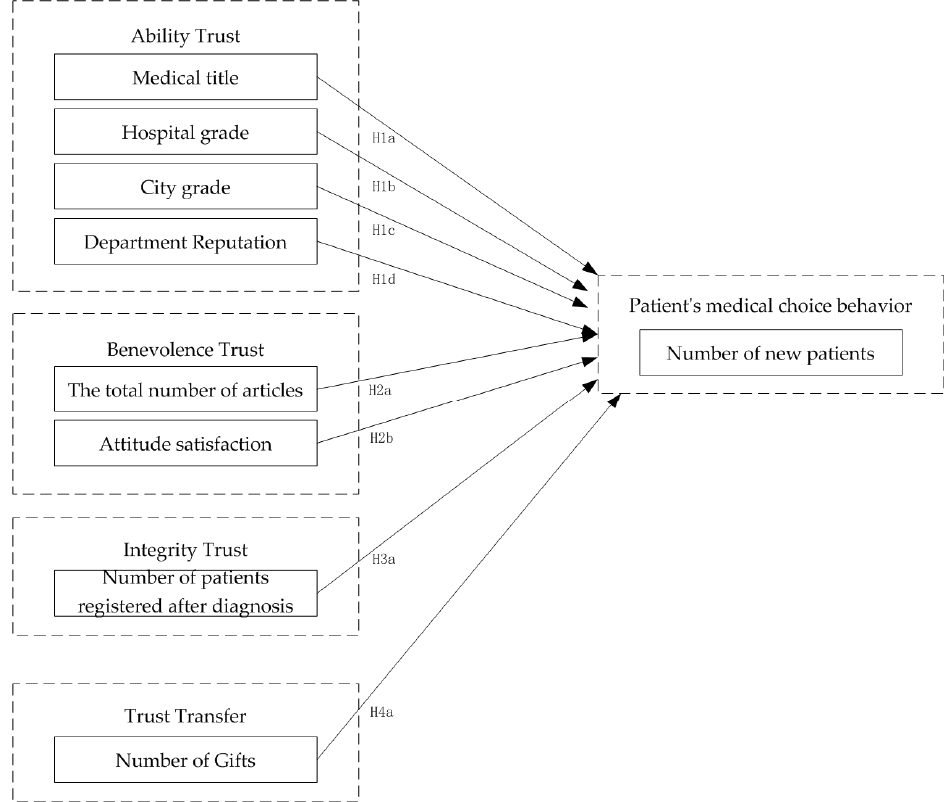
Figure 1. Hypothetical model of influencing factors of patients’ medical choice behavior.